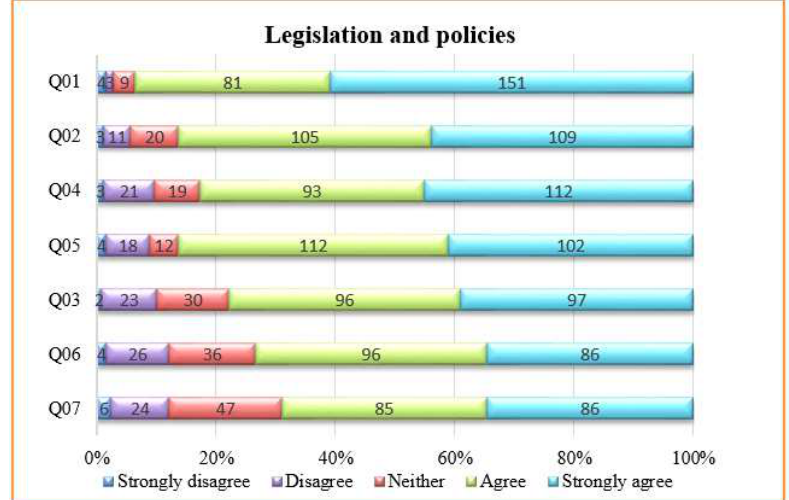
Figure 2. Results for legislation and